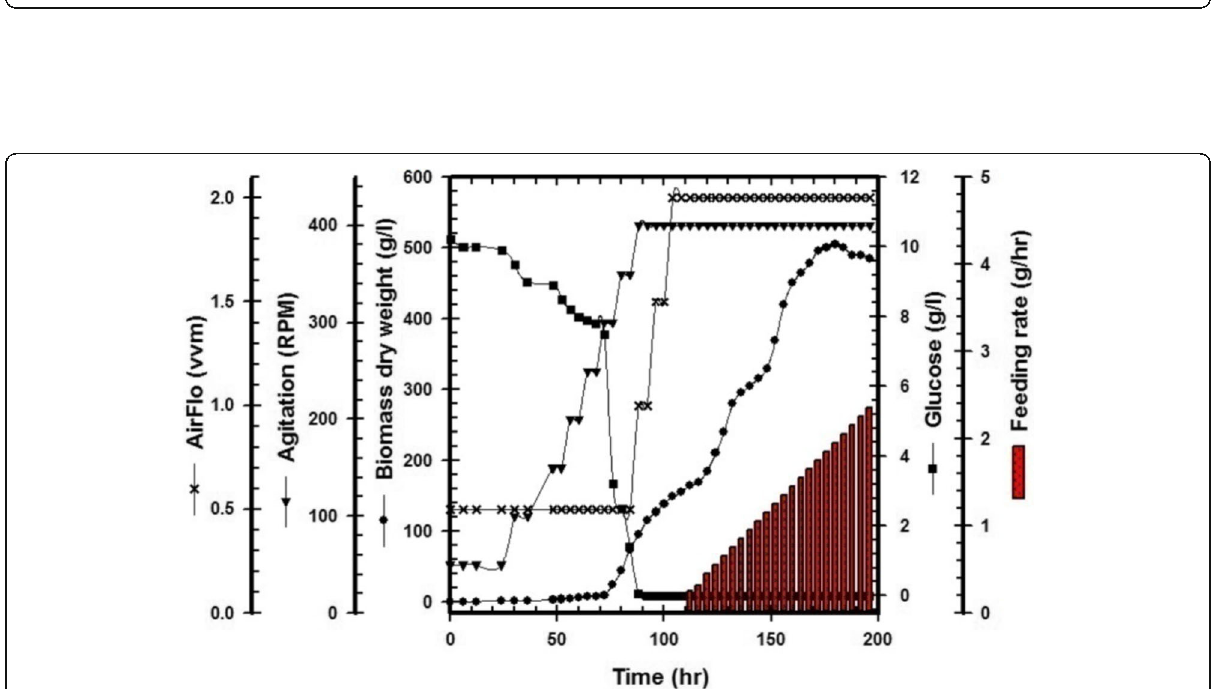
Fig. 5 Time course of biomass dry weight (g/L), glucose consumption (g/L), agitation rate (RPM), airflow (vvm), and feeding rate (g/h) based on batch and fed-batch cultivation of endophytic T. harzianum using a 7-L Bioflo310 bioreactor. The feeding commenced at 80 h after batch cultivation and continued exponentially up to 196